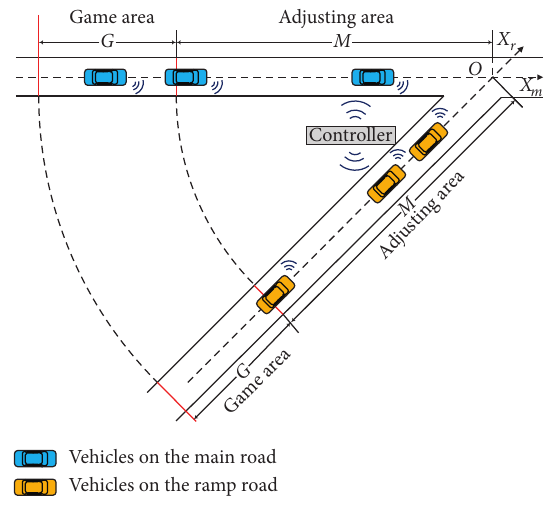
Figure 1: General framework of the proposed